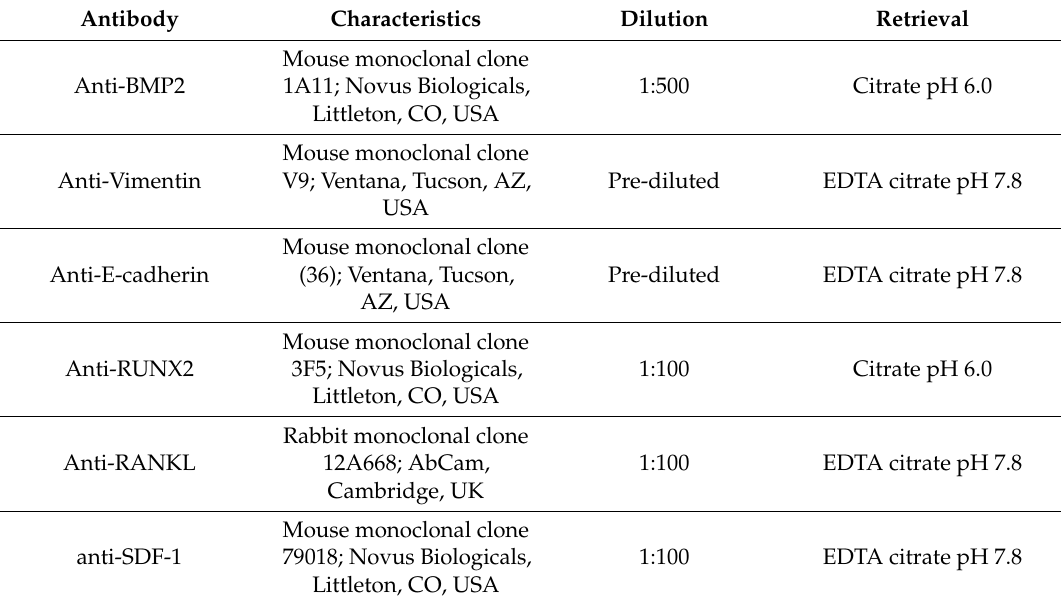
Table 1. List of primary